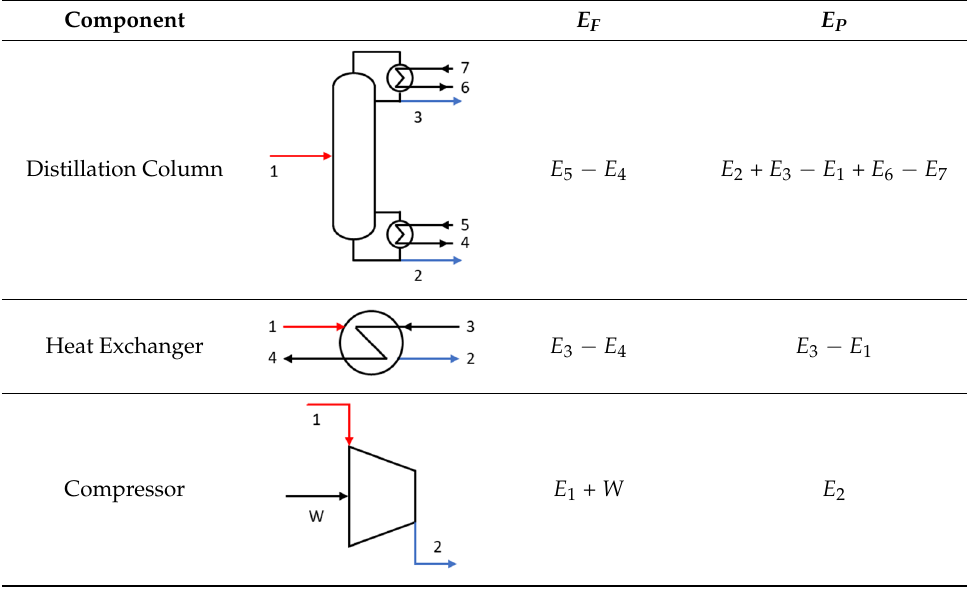
Table 5. Exergy of fuels and products for different components.